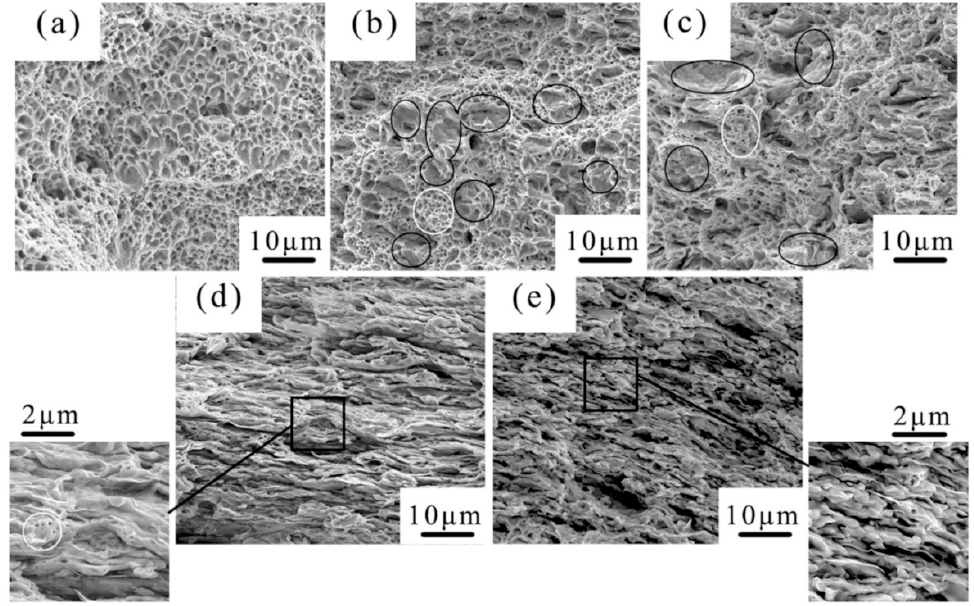
Figure 18. Surface images (SEM) of pure Cu and GNPs–Cu nanocomposites: ( a ) Pure Cu, ( b ) 0.2 vol.% GNPs–Cu, ( c ) 0.8 vol.% GNPs–Cu, ( d ) 2.0 vol.% GNPs–Cu and ( e ) 4.0 vol.% GNPs–Cu [53] (Copyright Elsevier, 2016, Carbon).